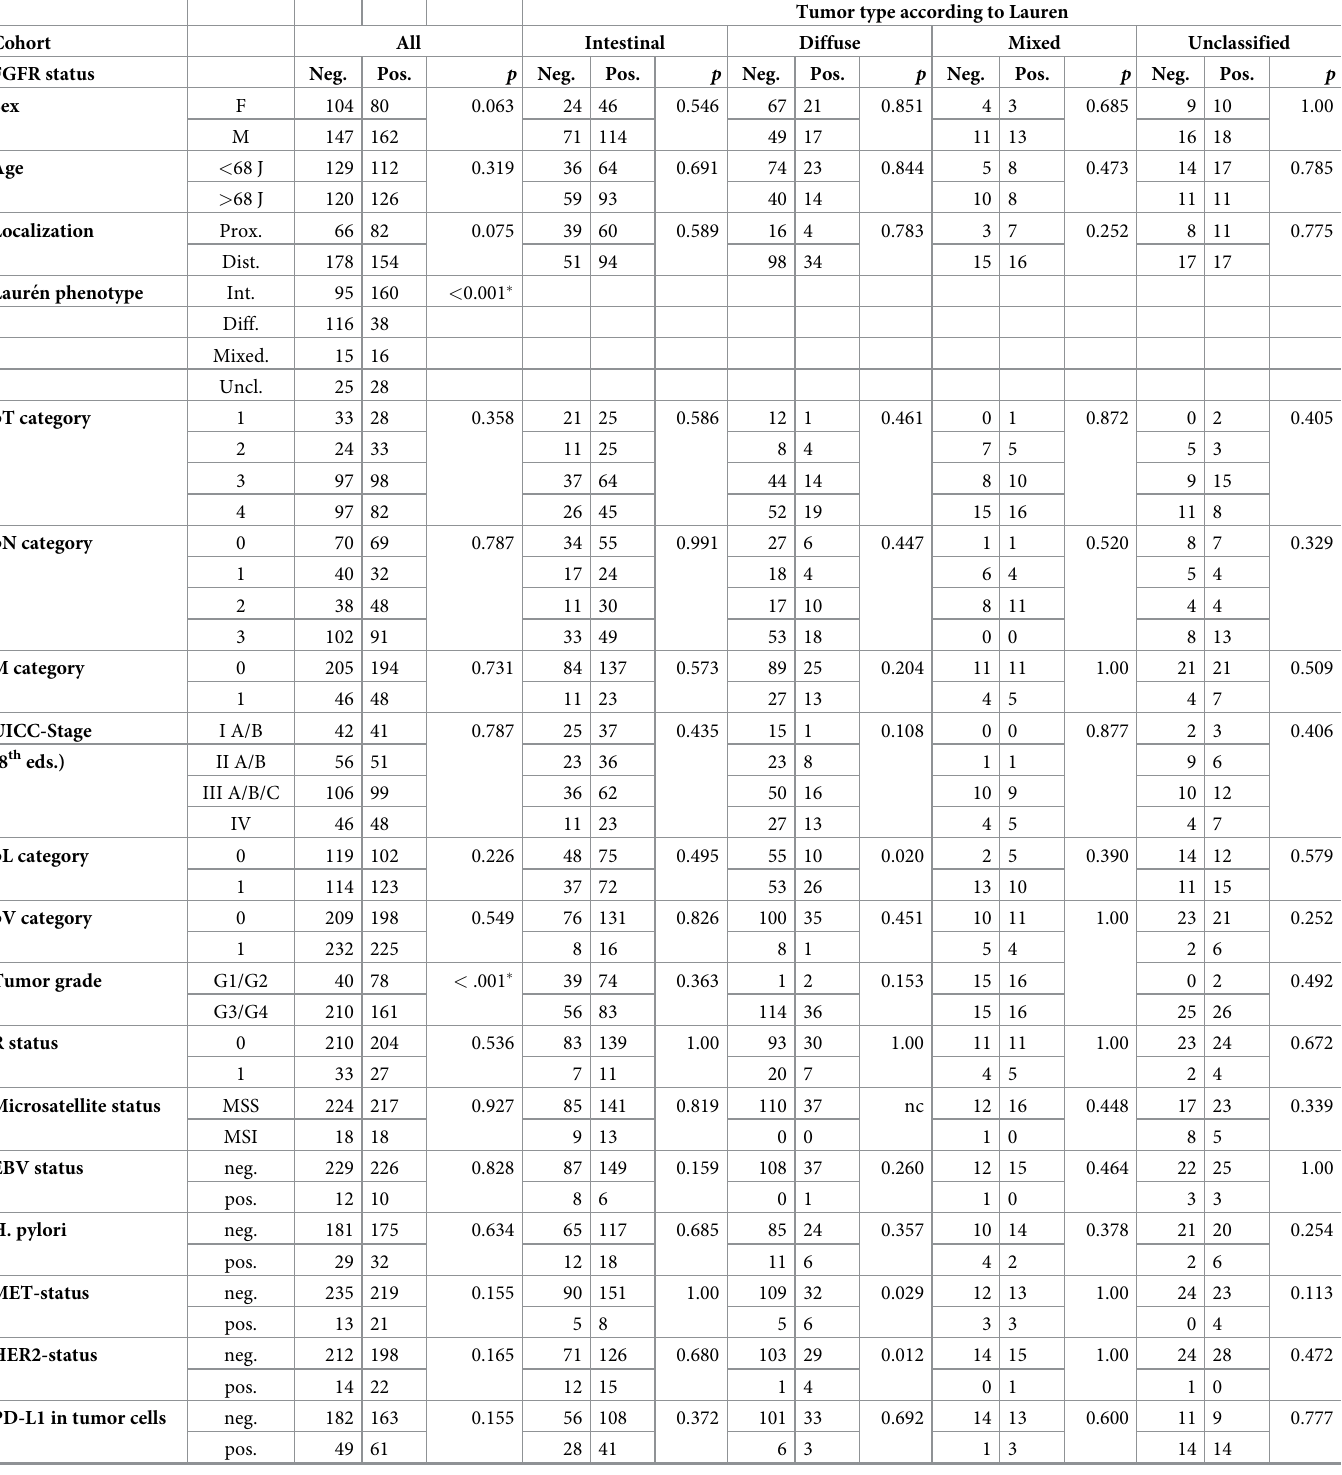
Tumor type according to Lauren